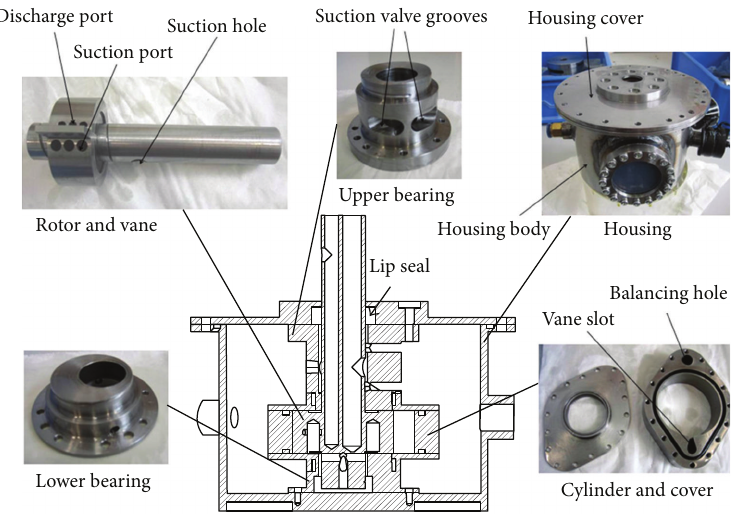
Figure 2: The revolving vane engine components and sectional drawing [25].